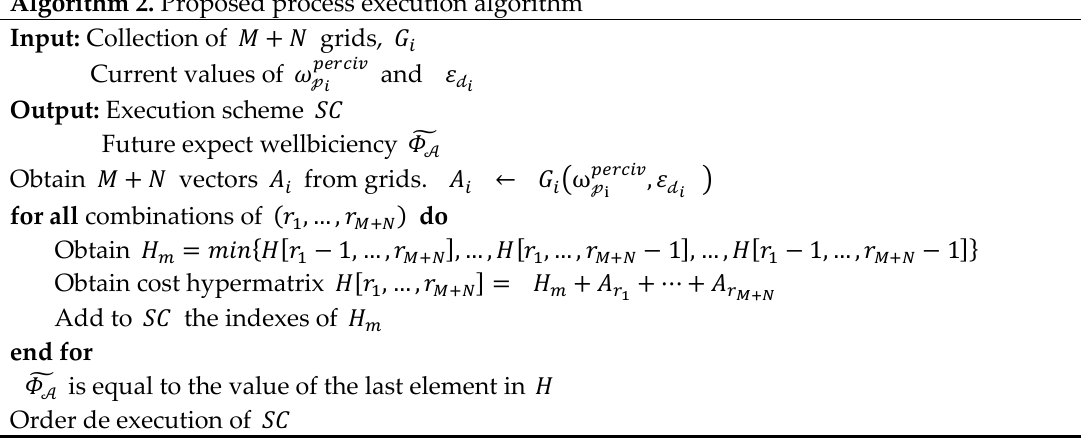
Algorithm 2. Proposed process execution